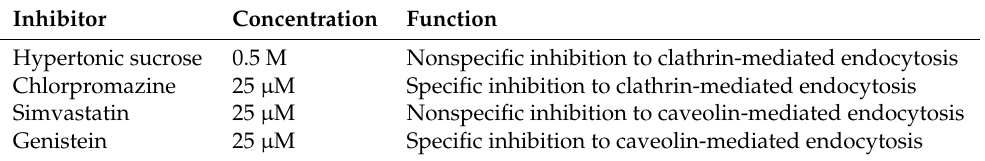
Table 1. Concentration and function of physiological inhibitors used in the cellular trafficking study. Inhibitor Concentration Function Hypertonic sucrose 0.5 M Nonspecific inhibition to clathrin-mediated endocytosis Chlorpromazine 25 µ M